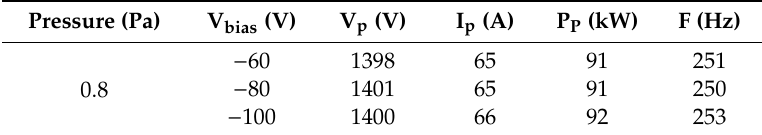
Table 1. Experimental parameters used for the deposition of Diamond-like Carbon (DLC) films in pure Ar plasma.